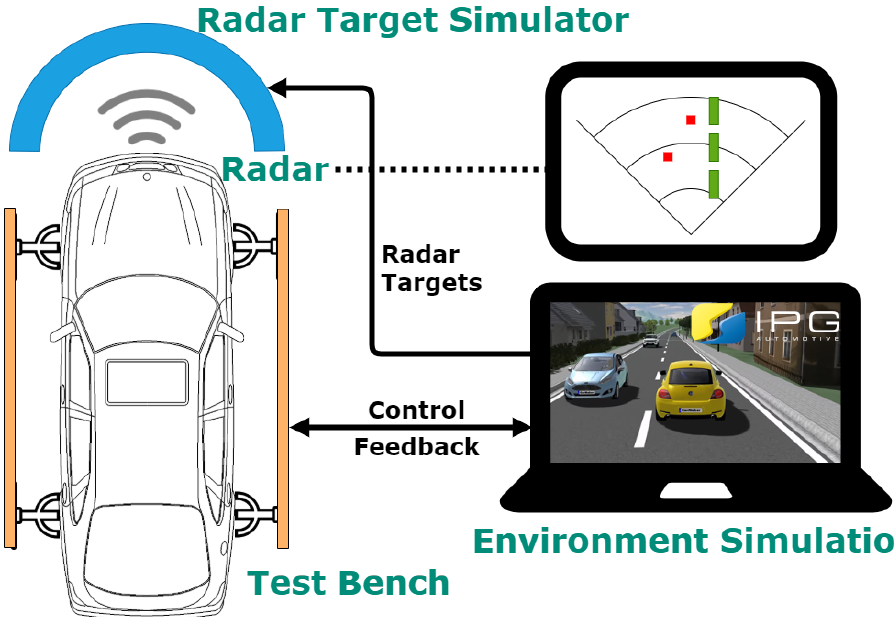
Figure 1. Overall system